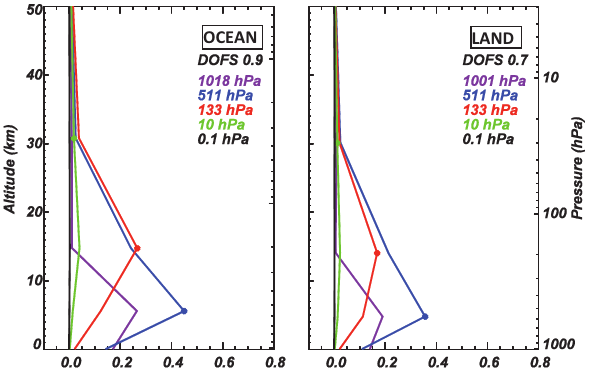
Fig. 5. Errors for a single target (left) and a 100-target average (right). For the single target, the dominant error is the cross-state error, which results from the propagation of errors from tempera- ture, water, surface temperature, and clouds into CO 2 . For the 100- target average, all errors except for self-smoothing, which results from sub-optimal sensitivity, are assumed to add randomly. Self- smoothing is the dominant error for the 100-target average.